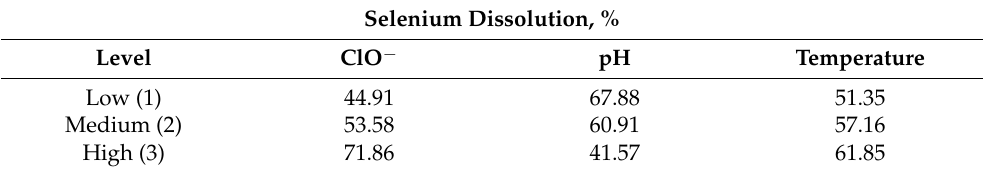
Table 6. Average response to the evaluated variables.